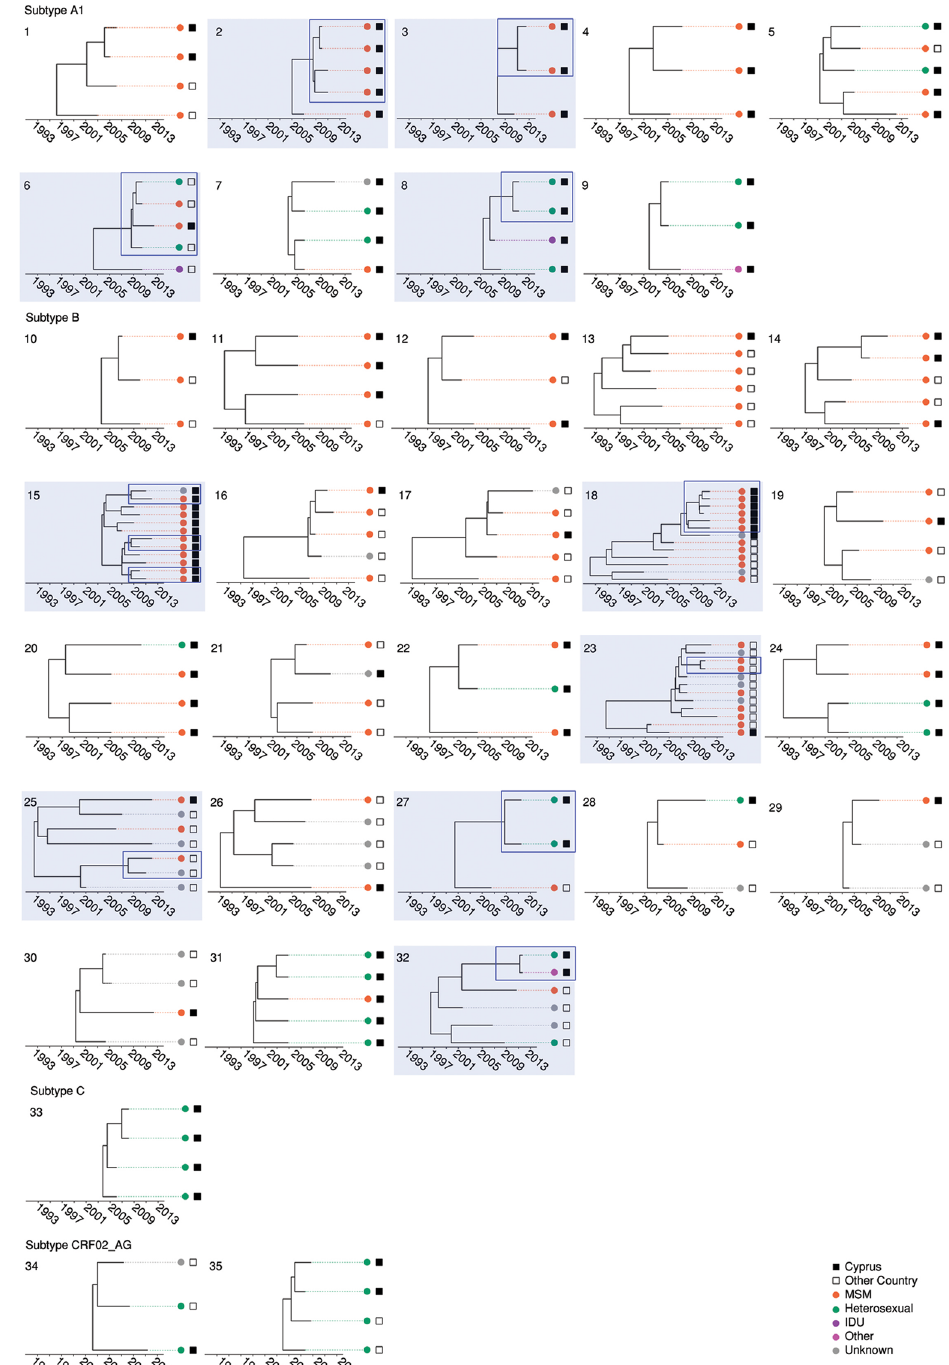
Figure 3. Transmission Clusters (TC). Thirty-five clusters were identified. Clusters 1–9 belong to subtype A1, clusters 10–32 to subtype B, cluster 33 to subtype C and clusters 34–35 to subtype CRF02_AG. The TCs are numbered according to HIV-1 subtype (A1, B, C, F and CRF02_AG) and the decreasing percentage of men having sex with men (MSM) individuals in the clusters within each subtype. TCs that contain active clusters are highlighted in light blue and clusters that were still active in the past five years according to the depth of the cluster are outlined in dark blue rectangles. The colored circles at the tips of the tree show the risk group and squares represent the country of sampling (see color code at the bottom of the